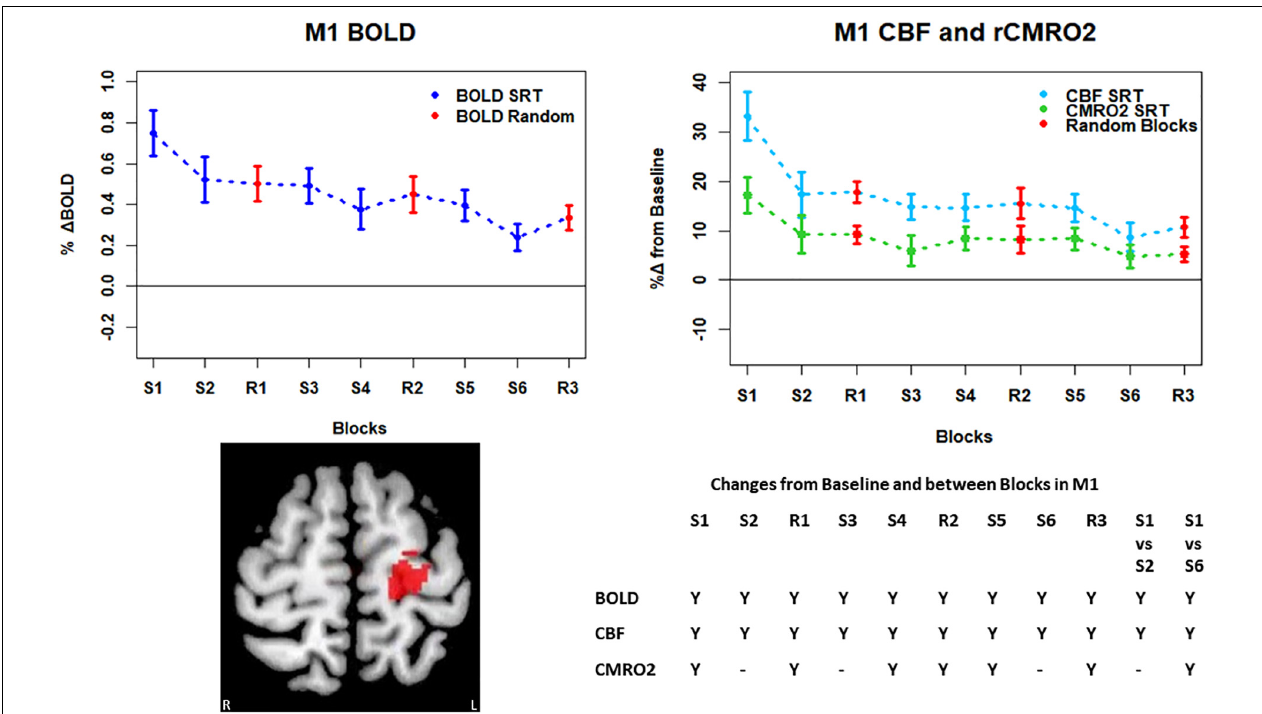
FIGURE 5 | Mean ± SEM SRT task responses in M1. Plots show a mean reduction in BOLD and CBF across task blocks. S1 = SRT block 1, R1 = random block 1. Y = Yes to indicate statistically significant ( p < 0.05), signal changes from baseline and between first and second and first and last SRT blocks. BOLD and CBF showed significant increases from baseline across all sequence and pseudorandom task blocks. There were also significant reductions in BOLD and CBF between sequence blocks S1 and S2 and S1 and S6. The CMRO 2 was significantly elevated from baseline across all blocks except squence blocks S2 and S6. There was also a significant reduction in CMRO 2 between S1 and